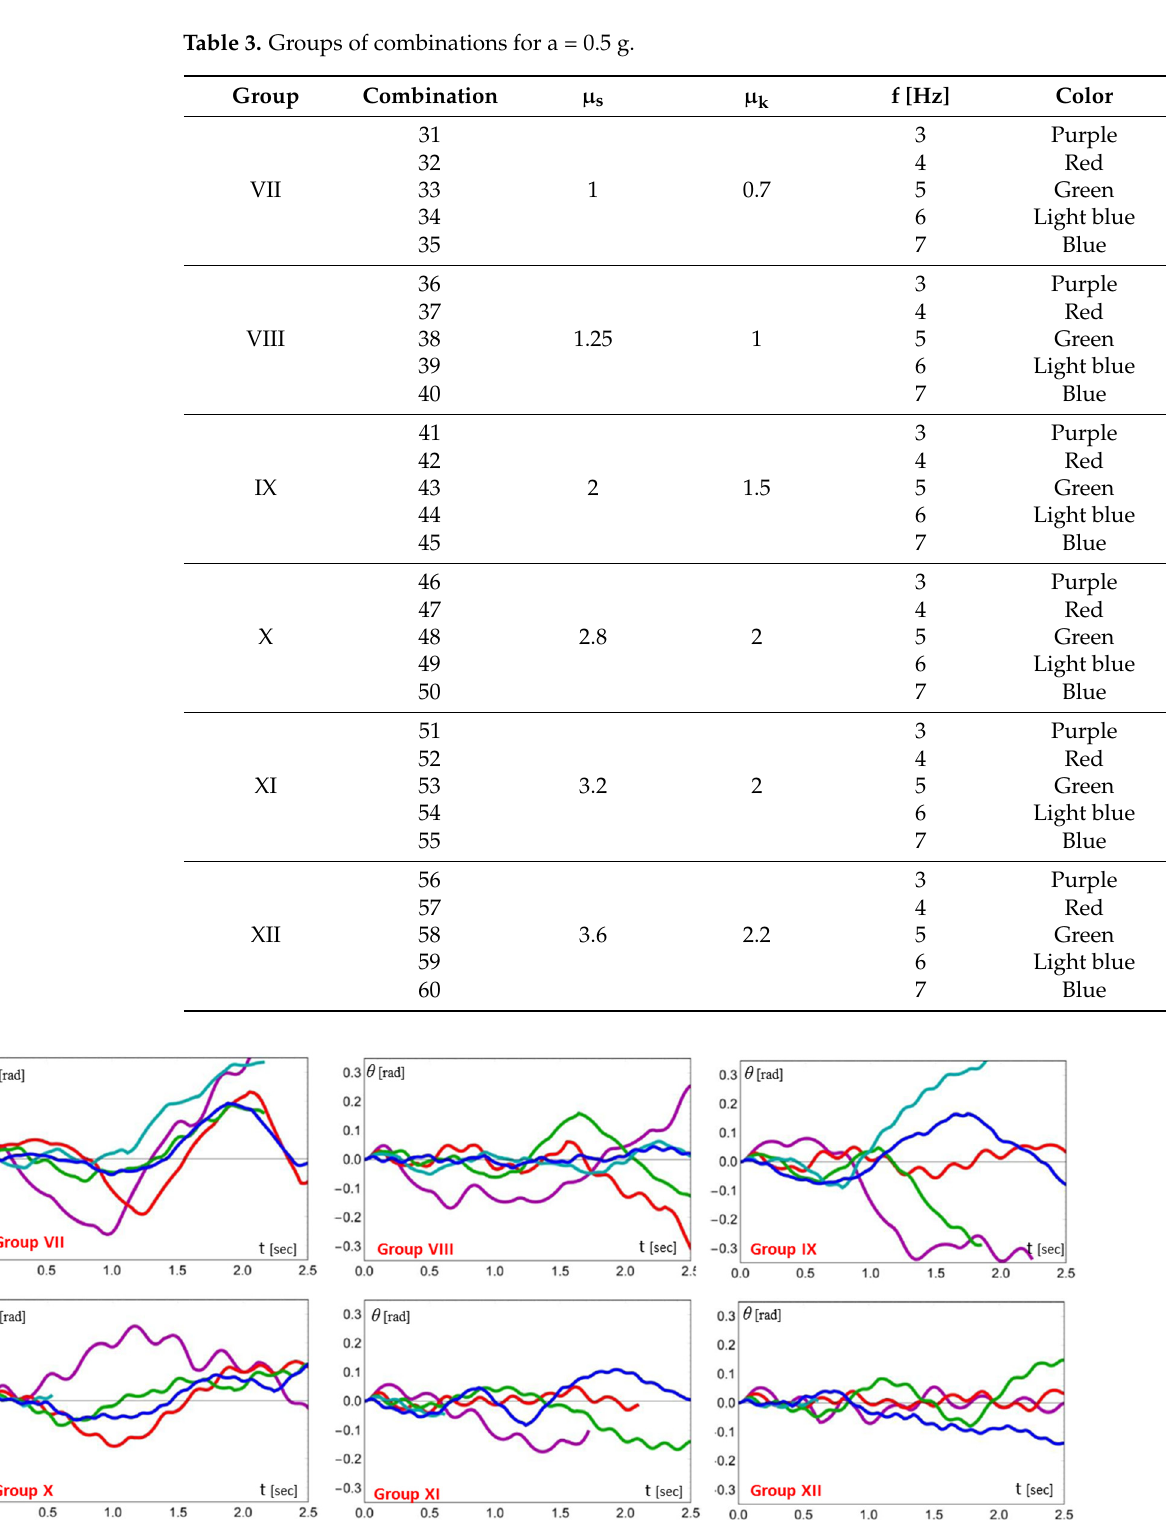
Table 3. Groups of combinations for a=0.5 g.